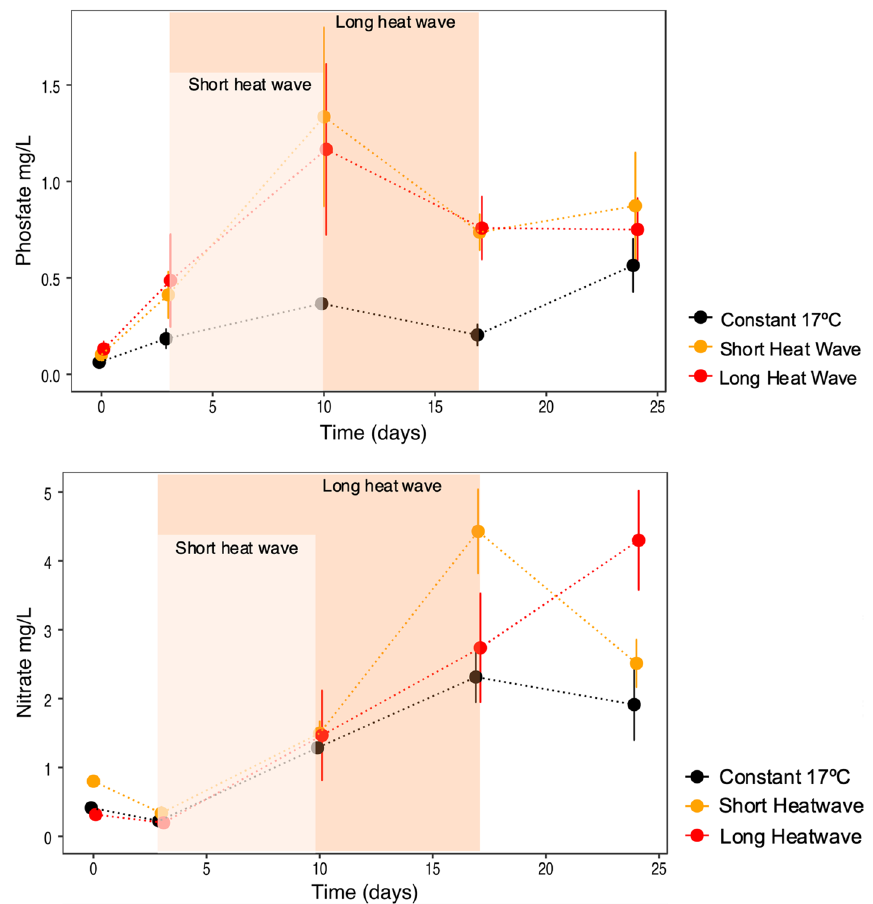
Figure 3. Phosphate and nitrate concentrations in the water column throughout the experimental procedure, considering the three temperature treatments. Graphs done with ggplot2 from R software (https:// ggplo t2. tidyv erse. org) and figure compiled with INKSCAPE (https:// inksc ape.